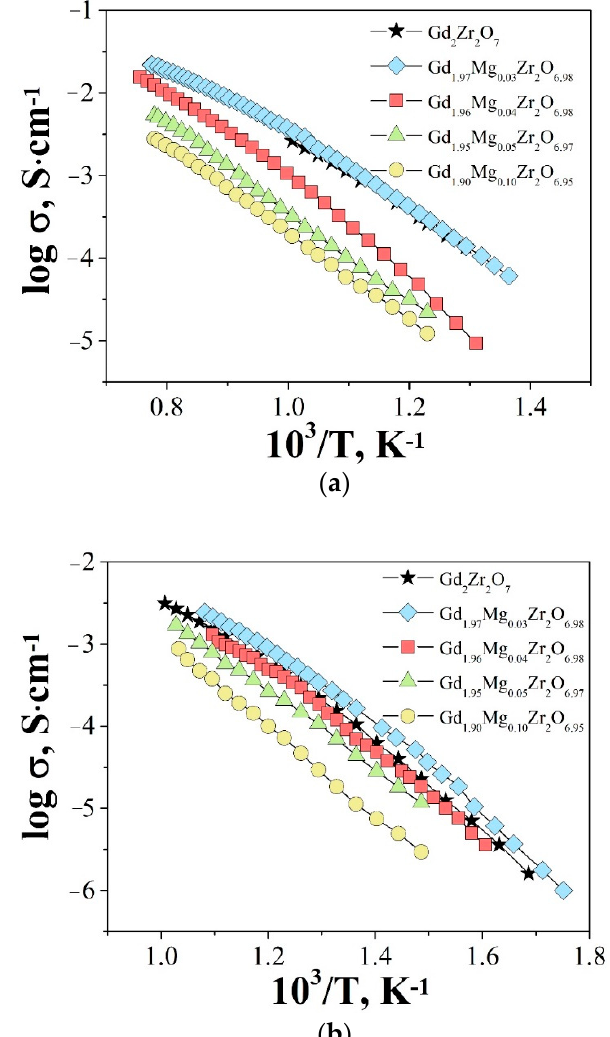
Figure 6. Temperature dependencies of total ( a ) and bulk ( b ) conductivities for Gd 2 − x Mg x Zr 2 O 7 − x/2 in air.